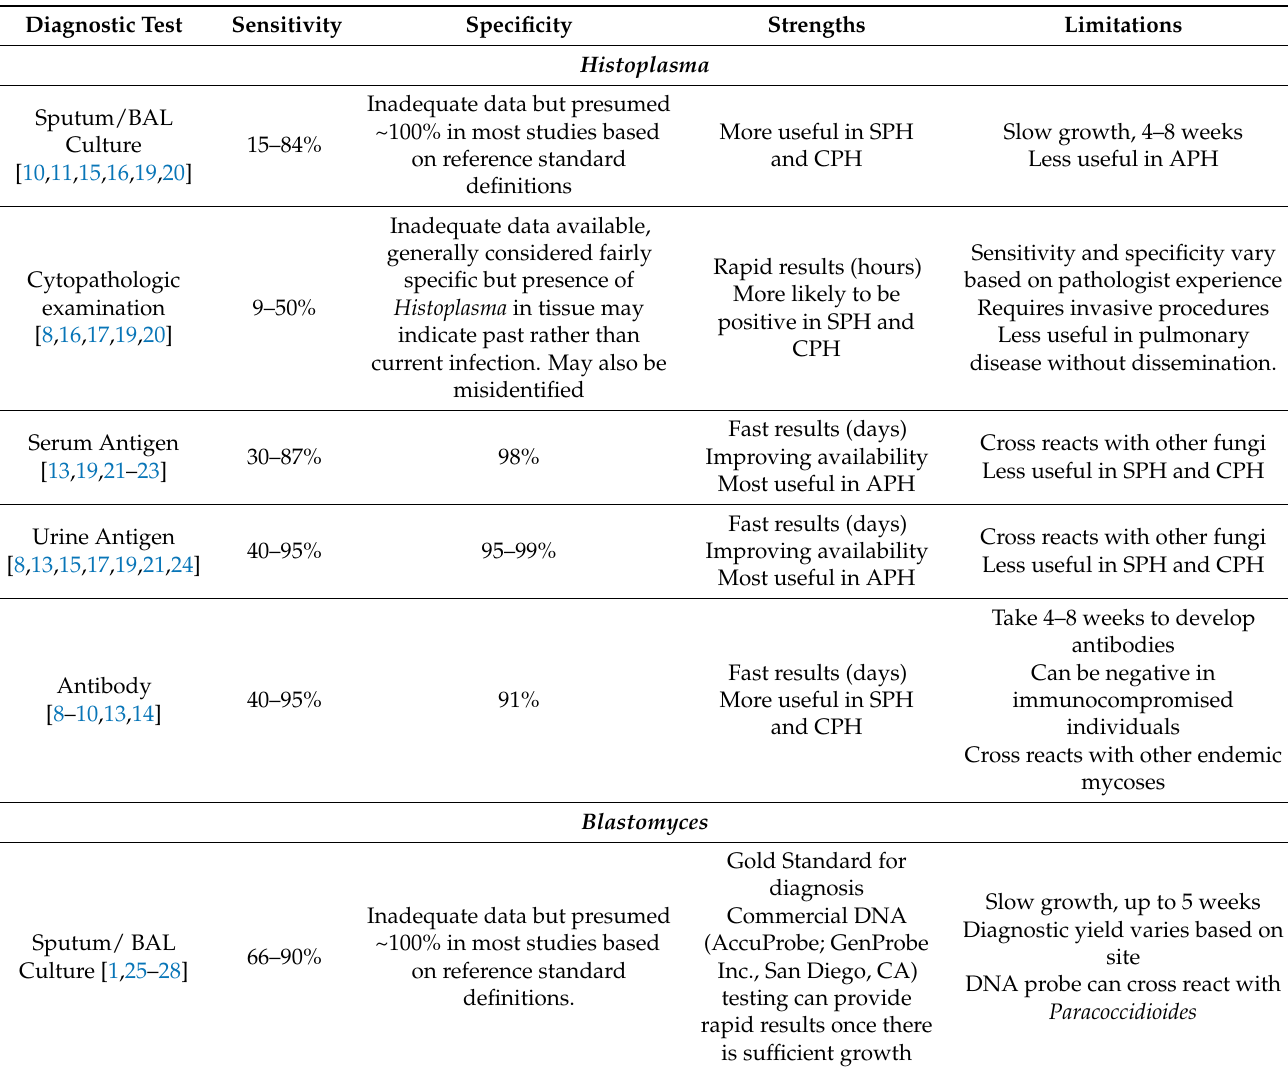
Table 2. Comparison of diagnostic tests utilized in the diagnosis of pulmonary infections due to endemic